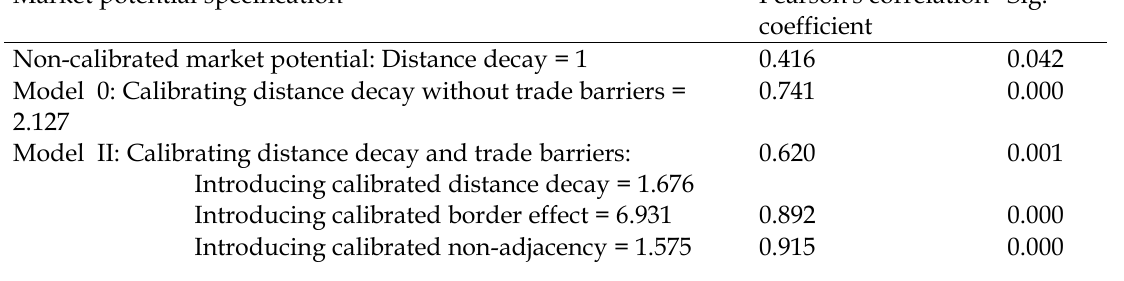
Table 11. Correlation coefficients between the actual international trade matrix and market potential